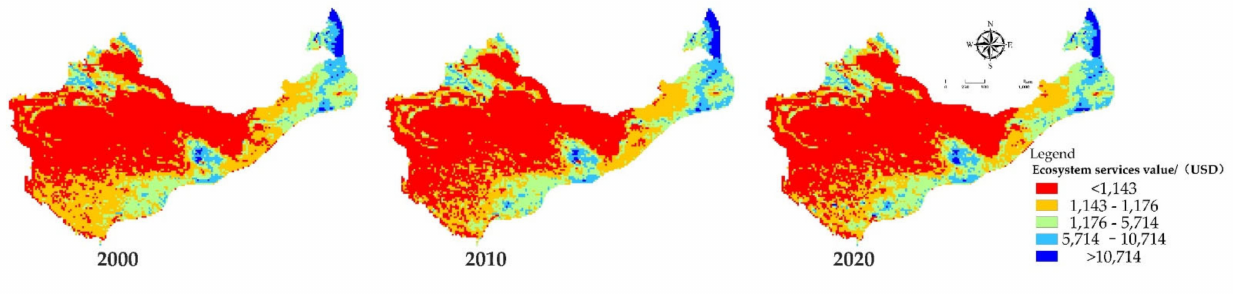
Figure 2. Spatial distribution of ecosystem service value at 20 km scale in 2000, 2010, and